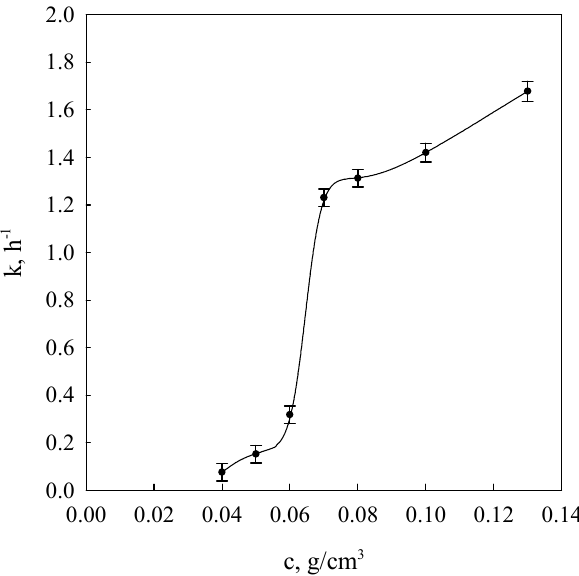
Figure 2. Concentrational relationships of crosslinking kinetics constants ( k ) of starch gels at different concentrations starch in systems. The values are expressed as means ± SD ( n = 3).